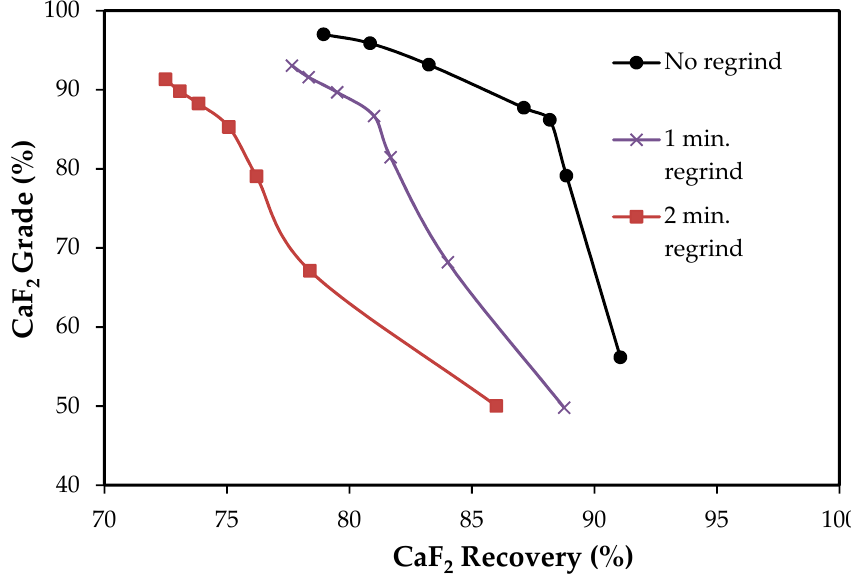
Figure 6. E ff ect of concentrate regrind on CaF 2 grade and Figure 6. Effect of concentrate regrind on CaF 2 grade and recovery.